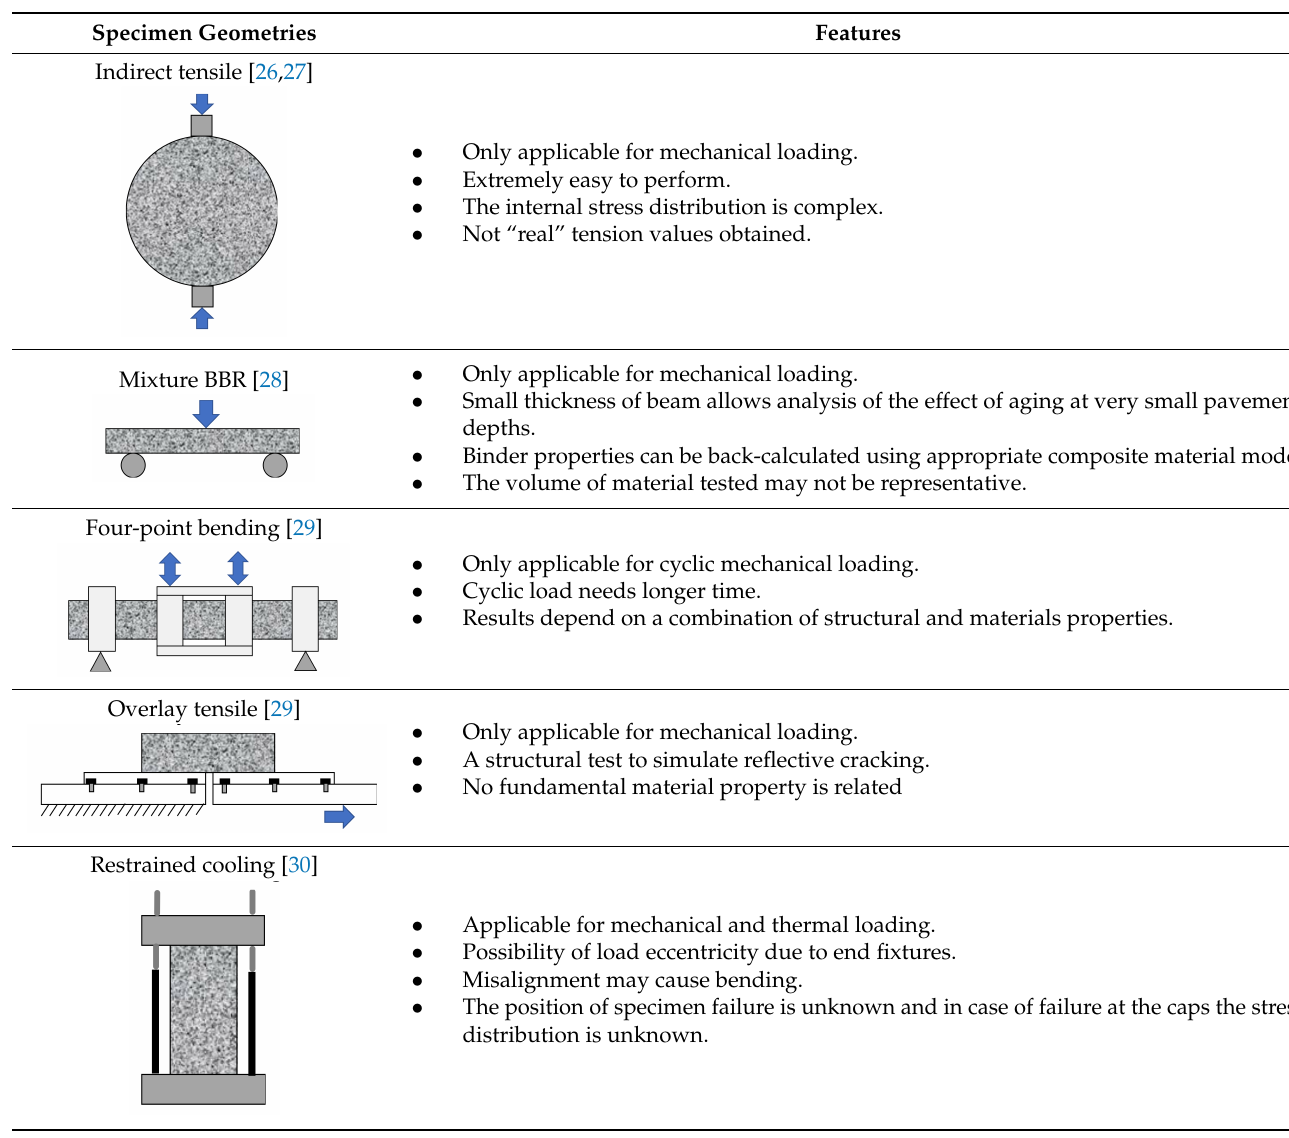
Table 1. Specimen geometry and features of common unnotched asphalt mixture fracture test configurations (tests on unnotched